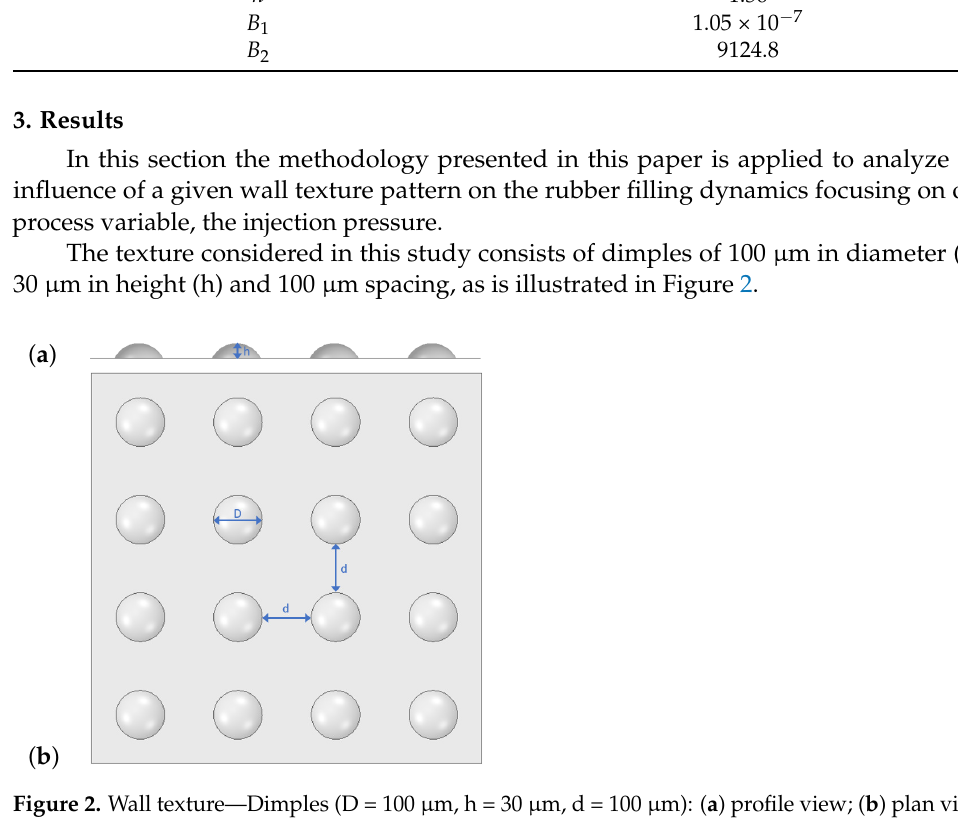
Figure 2. Wall texture—Dimples (D = 100 µ m, h = 30 µ m, d = 100 µ m): ( a ) profile view; ( b ) plan